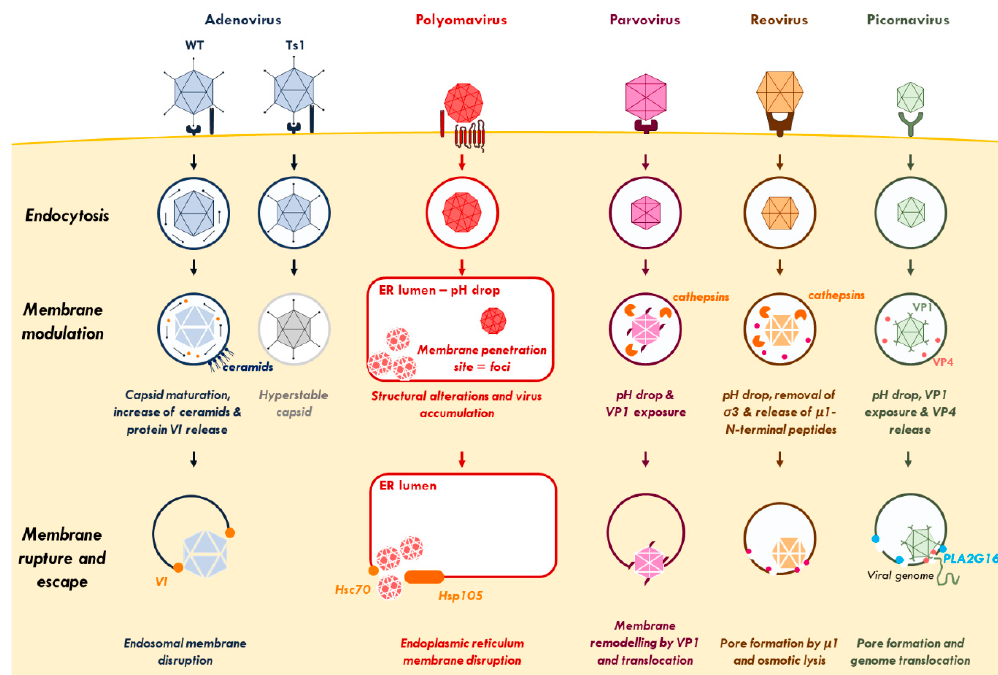
Figure 1. Virus-inflicted membrane damage. After binding to cell-surface receptors, viruses are internalized through endocytosis. Once in the endosome, adenovirus capsid undergoes partial disassembly and releases protein VI. The increase of ceramide concentration enhances the binding of protein VI to the endosomal membrane and its subsequent rupture. Polyomavirus-containing endosomes are targeted to the endoplasmic reticulum (ER) where the virus undergoes conformational changes to penetrate the ER-membrane and escape to the cytosol. Parvovirus and reovirus require a pH drop and the action of endosomal cathepsins to induce conformational rearrangements, disrupt the endosome, and reach the cytosol. After endocytosis and conformational changes, picornaviruses rely on a cellular lipid-modifying enzyme (PLA2G16) to facilitate the translocation of its genome via selective pores across the endosomal membrane. See Section 1 for further details. Abbreviations: ER, endoplasmic reticulum; Hsc70, Heat shock cognate 71 kDa protein; Hsp105, Heat shock protein 105 kDa; PLA2G16, phospholipase A2 group